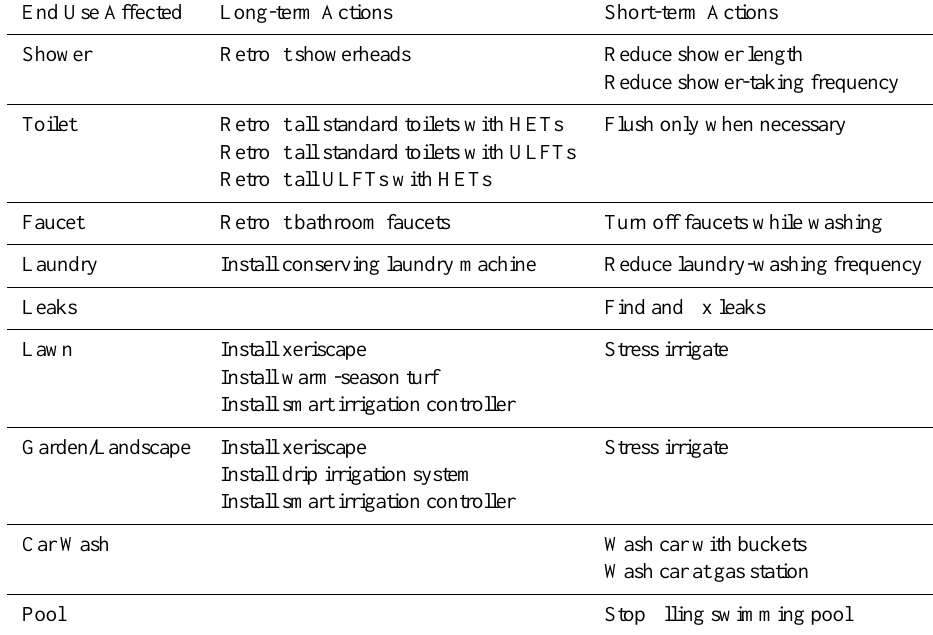
Table 2. Actions available to households in the least-cost conservation